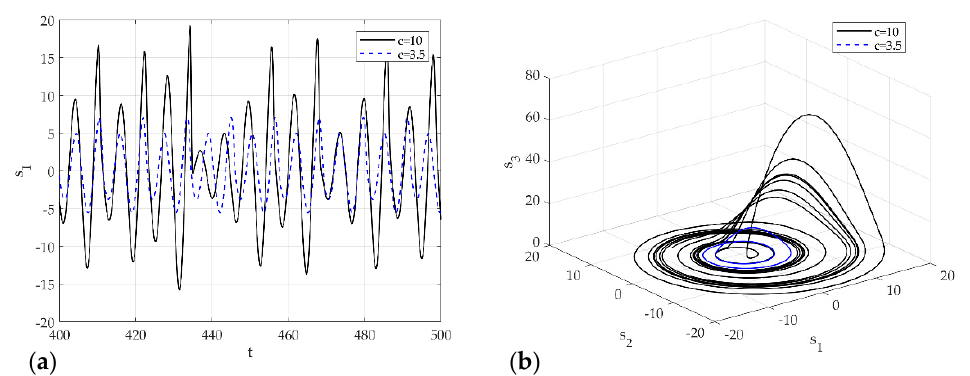
Figure 4. Dynamic solutions for the Rossler model for various c : ( a ) time analysis; ( b ) 3-D phase portrait.